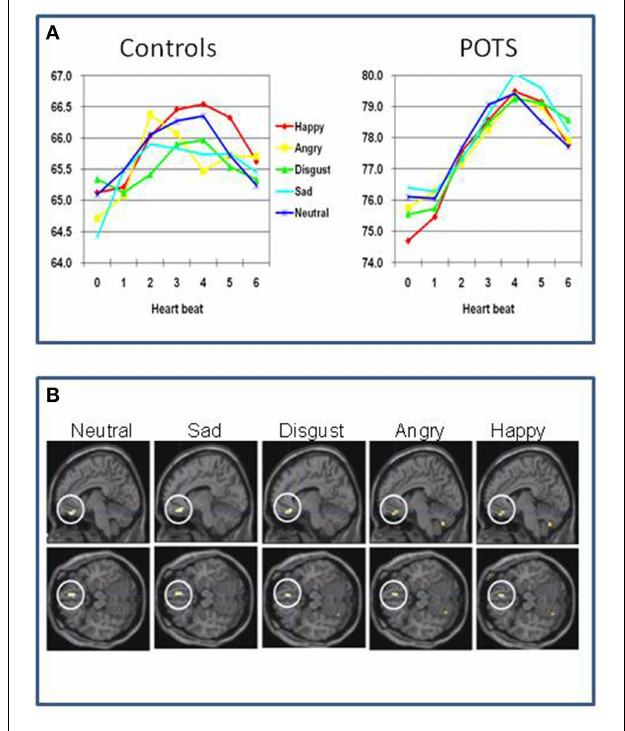
FIGURE 3 | Functional differences in brain of patients with postural orthostatic tachycardia syndrome (Postural Tachycardia Syndrome) (Umeda et al., 2009). (A) Differences between controls and Postural Tachycardia Syndrome patients in resting heart rate and evoked responses to neutral and emotional stimuli, characterized by accentuated prolonged cardiac acceleration in orienting response with lack of emotion specificity. (B) Differences in regional brain activity between Postural Tachycardia Syndrome and control participants showing exaggerated withdrawal of activity within ventromedial prefrontal cortex in Postural Tachycardia Syndrome patients when encountering emotional or neutral